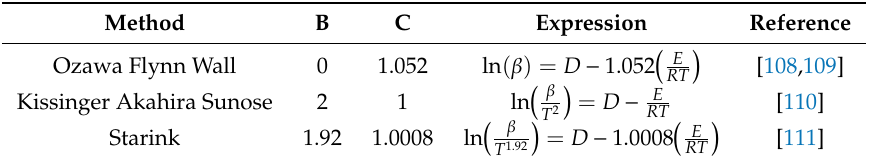
Table 2. Approximations for integral from, starting from Equations (11) and (12) (no piecewise integration here for